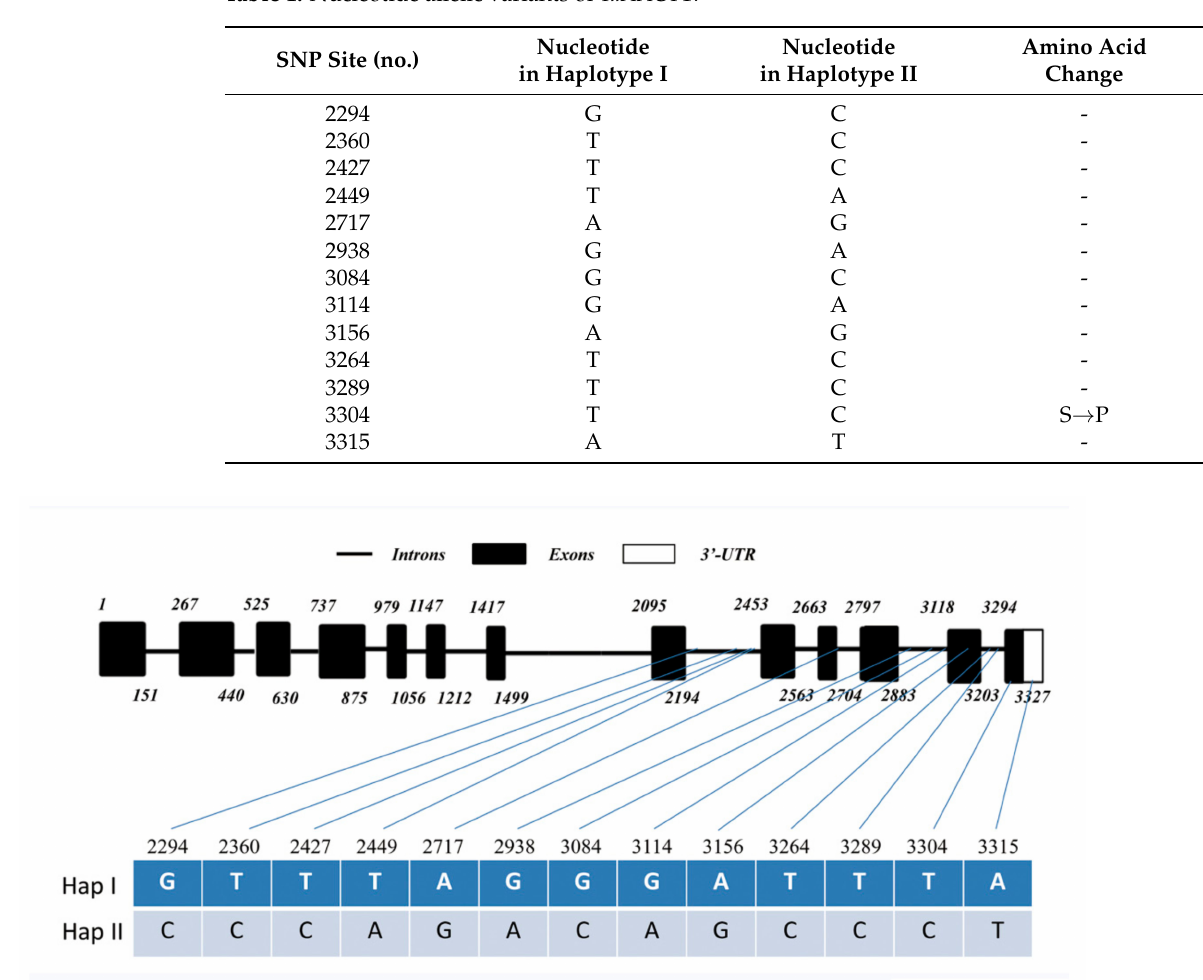
Table 1. Nucleotide allelic variants of TaAACT1 .